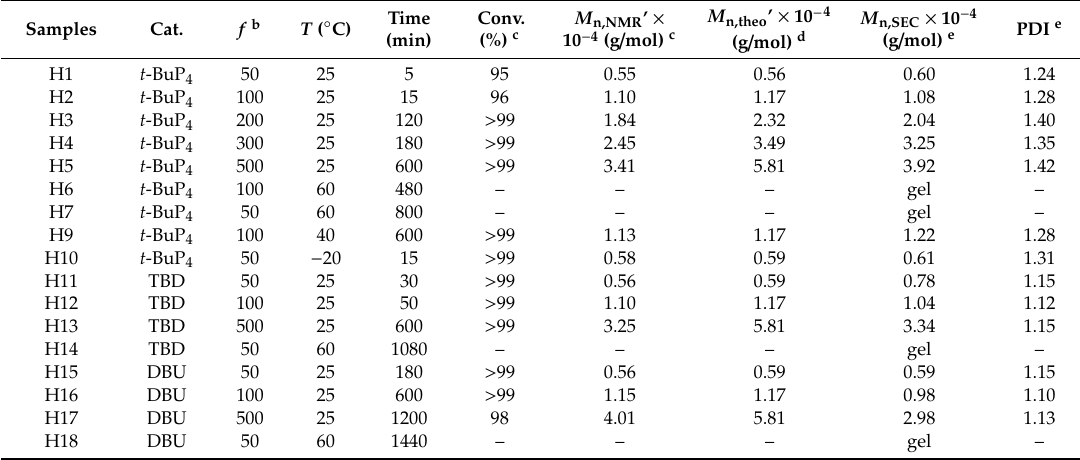
Table 1. Characterization data of ring-opening polymerization (ROP) of DXO with three organocatalysts at various conditions a